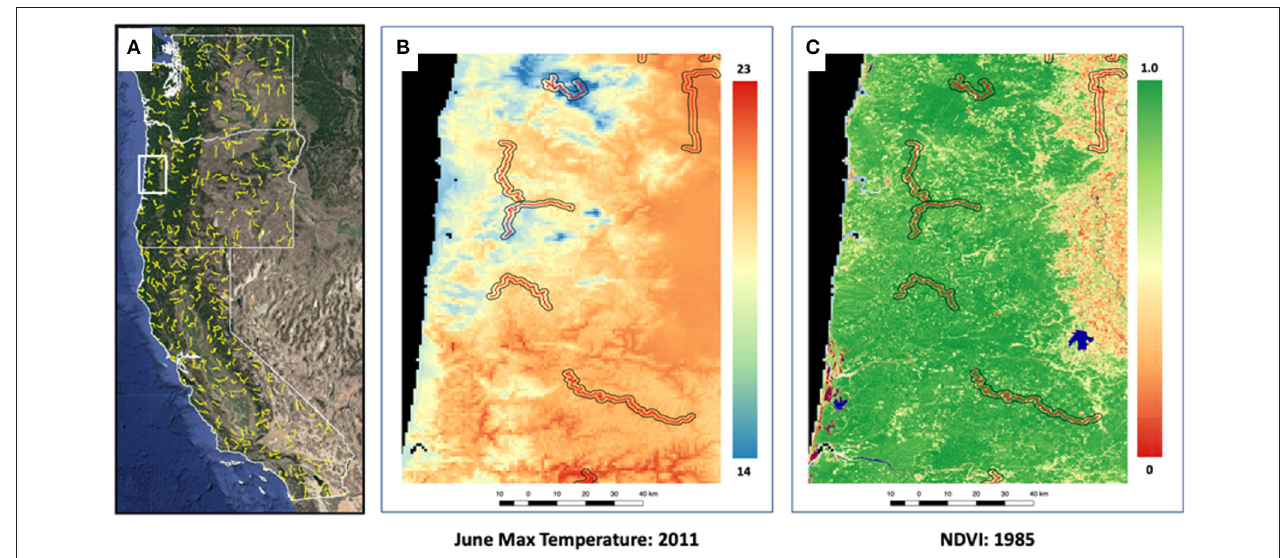
FIGURE 1 | Study area map showing Breeding Bird Survey (BBS) routes across Washington, Oregon and California (A) , along with finer-scale maps showing one climate variable (June maximum temperature) (B) and one land-cover variable (normalized difference vegetation index [NDVI]) (C) .